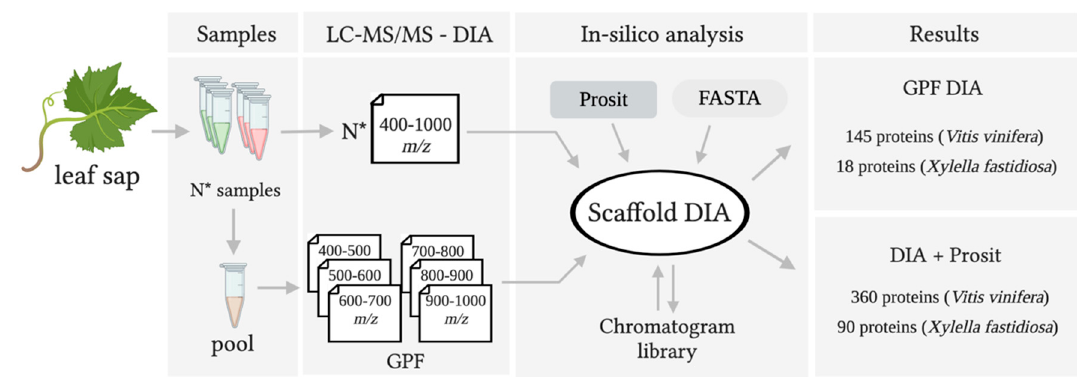
Figure 1. Quantification of peptides with chromatogram libraries workflow from grapevine leaf sap with Pierce’s disease. The chromatogram library generation was based on Searle et al. (2018). Created with BioRender.com.